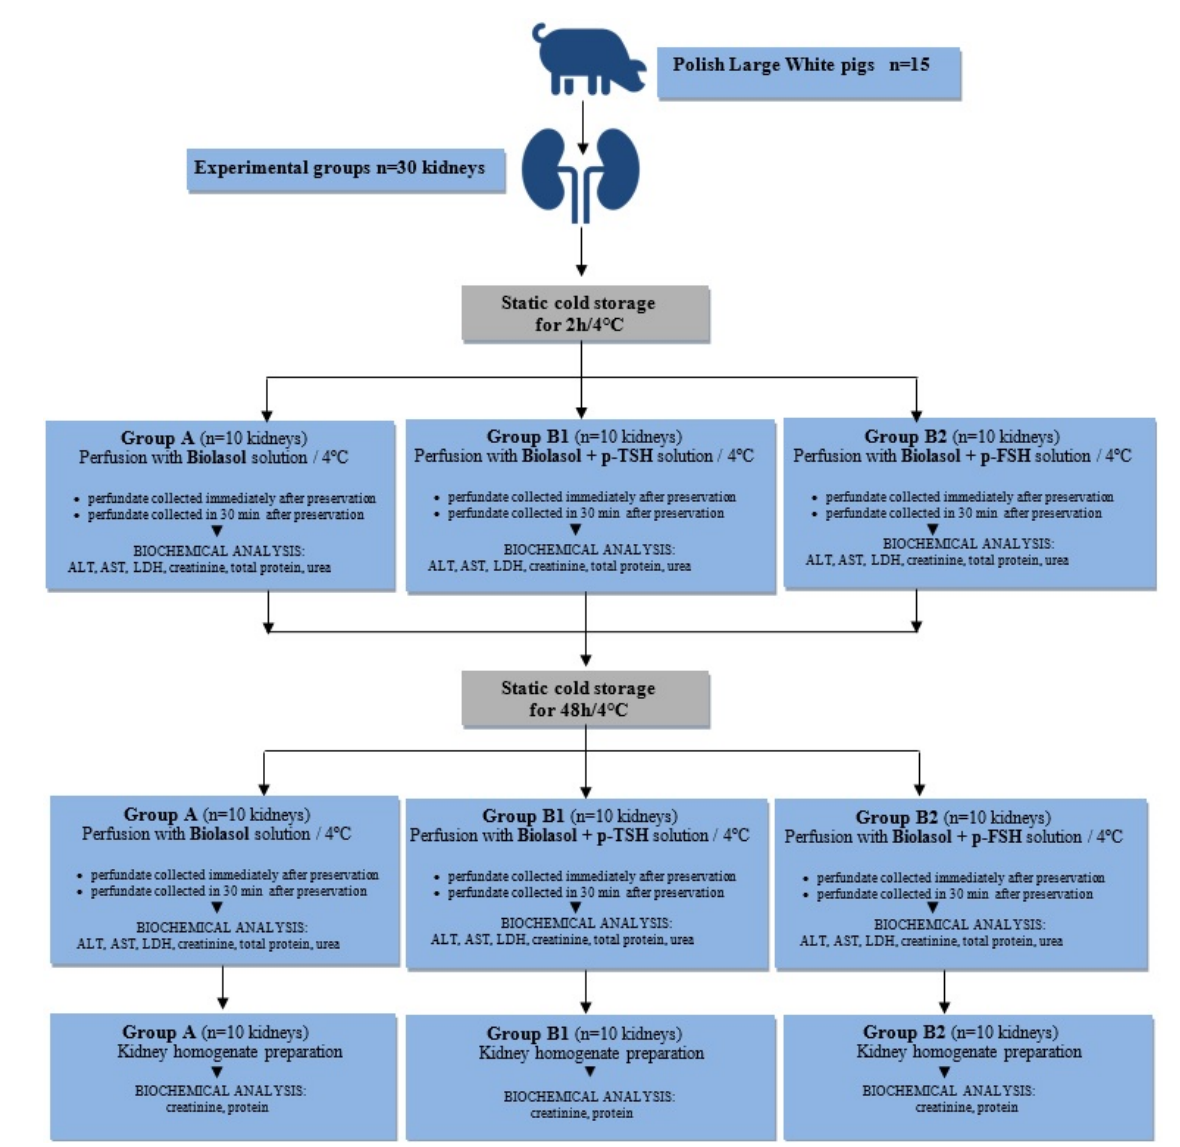
Figure 8. Study design.